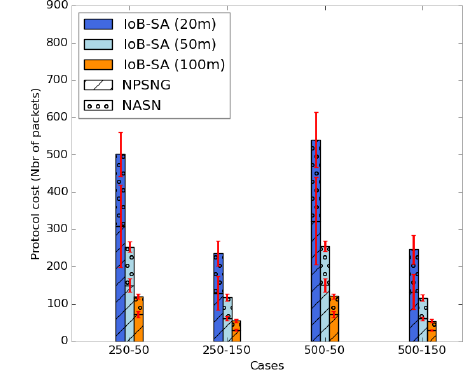
Figure 27. Average protocol cost for IoB-SA.